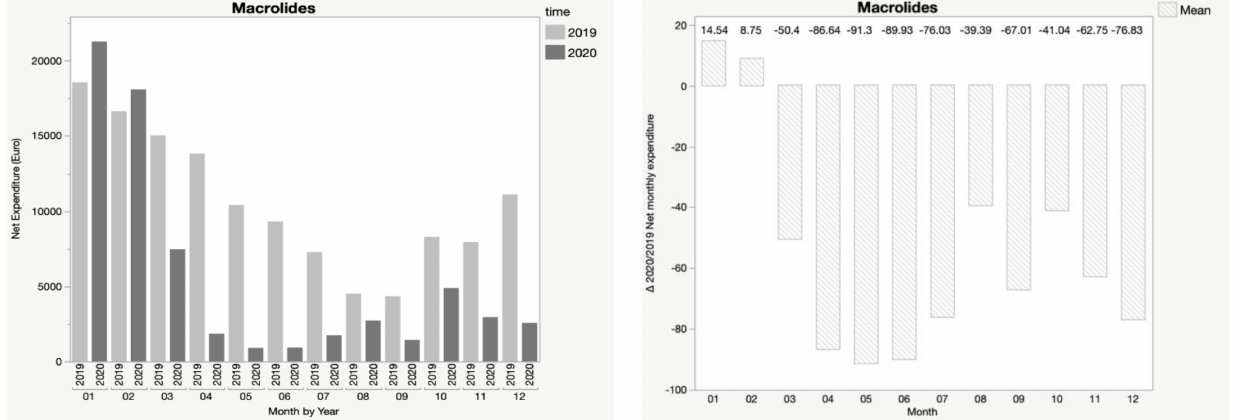
Figure 4. Trend in net expenditure (EUR) and delta 2020/2019 of net monthly expenditure of macrolides, from January through December of the years 2019 and 2020, in the study population of 35,787 children aged 0–14 years.